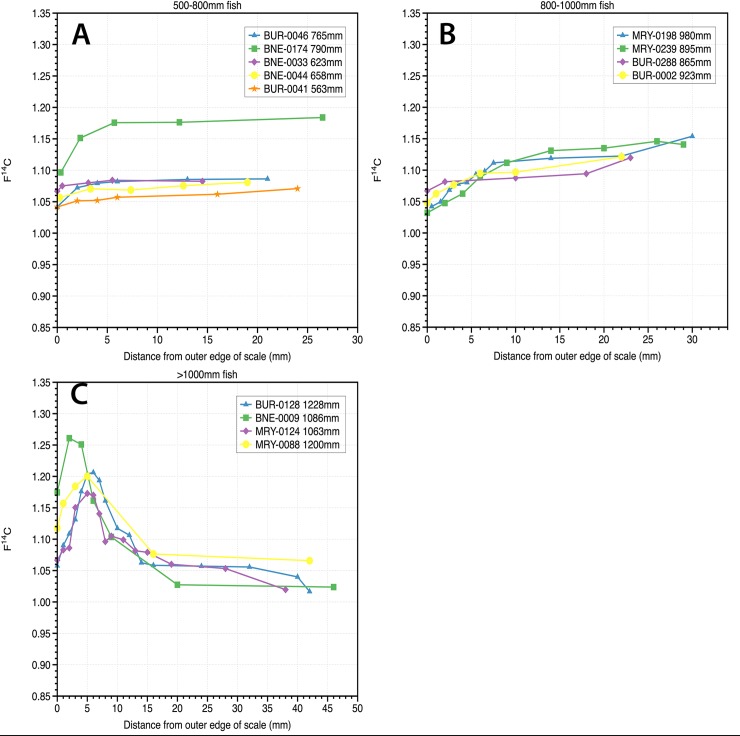
Radiocarbon results (F14C) from selected fish.A) Representative F14C from fish smaller than 800mm in length vs. distance from the outer edge of the scale B) Representative F14C from selected fish between 800-1000mm in length vs. distance from the outer edge of the scale. C) Representative F14C from fish >1000mm in length vs. distance from the outer edge of the scale. The radiocarbon bomb pulse is evident in the data from fish >1000mm in length.